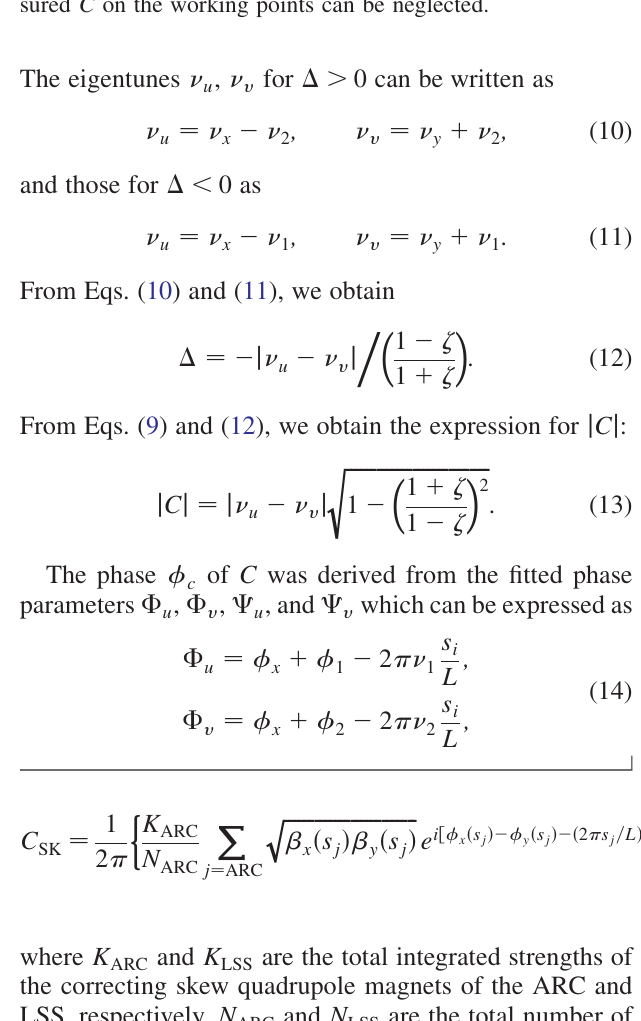
FIG. 3. The absolute values (filled circles) and phases (open circles) of C measured at several working points near the linear difference resonance. We see that the dependence of the mea- sured C on the working points can be